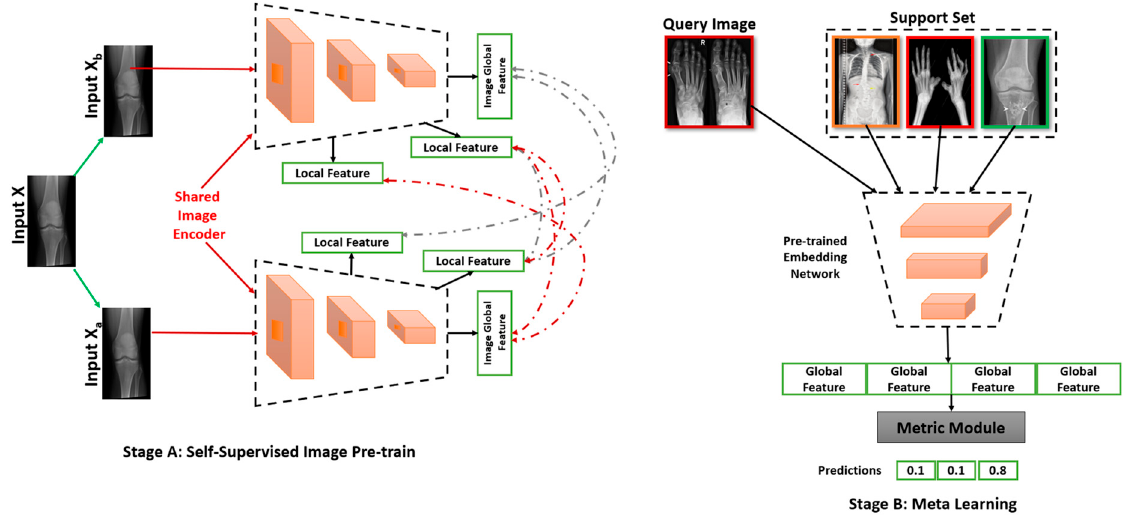
Figure 5. Diagrammatic representation of self-supervised learning.